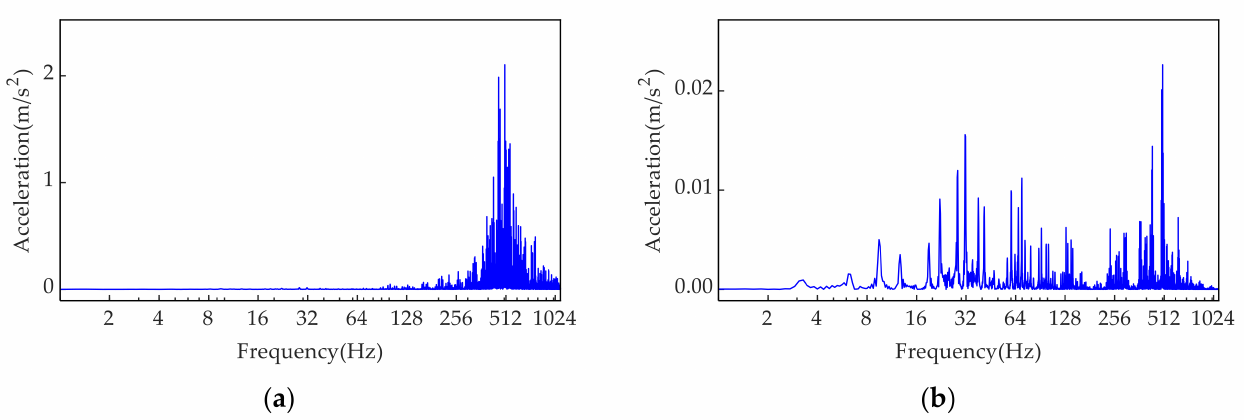
Figure 18. Frequency distribution of the vertical acceleration of the track slab under: ( a ) track short wave irregularity; ( b ) track medium-long wave irregularity.